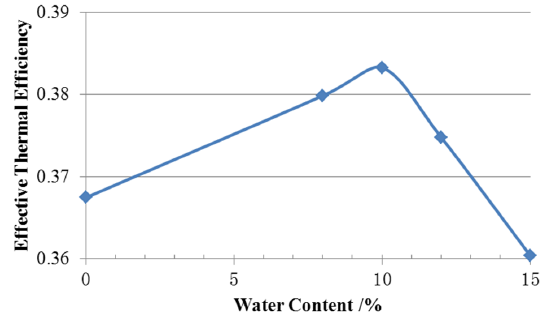
Figure 14. Variation tendency of brake thermal efficiency according to water content in fuel.